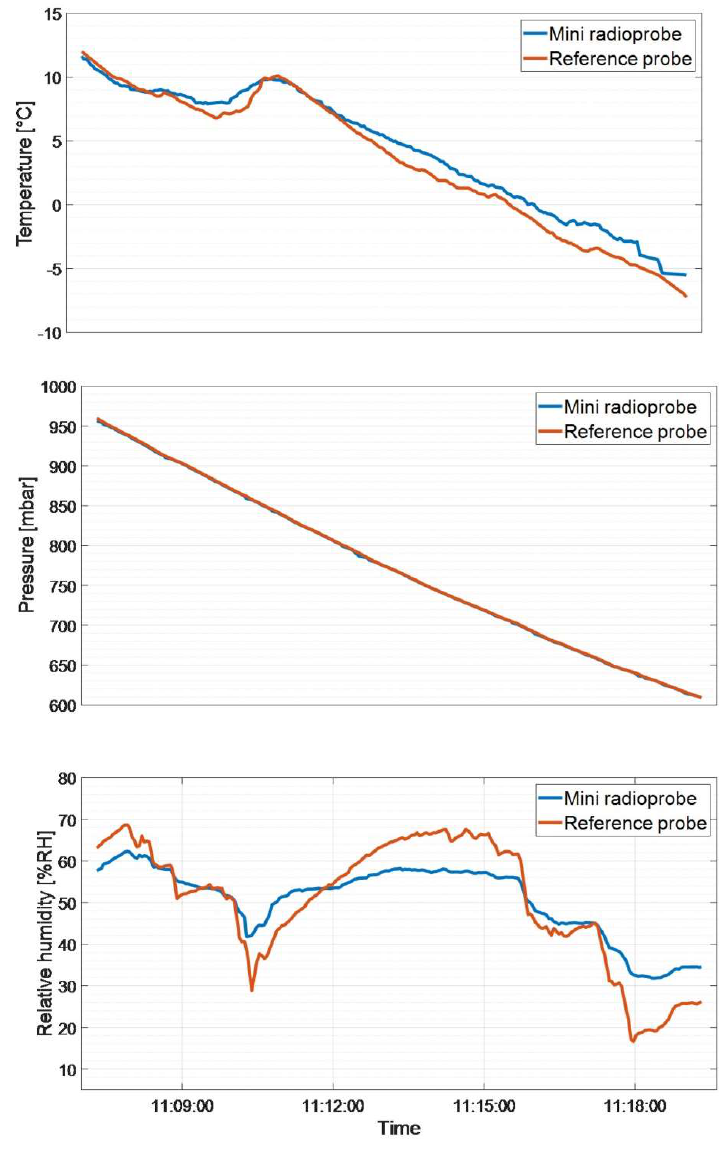
Figure 8. Comparison of temperature, pressure, and relative-humidity measurements between the Regional Agency for the Protection of the Environment (ARPA) reference sonde sensors and the radioprobe sensors.